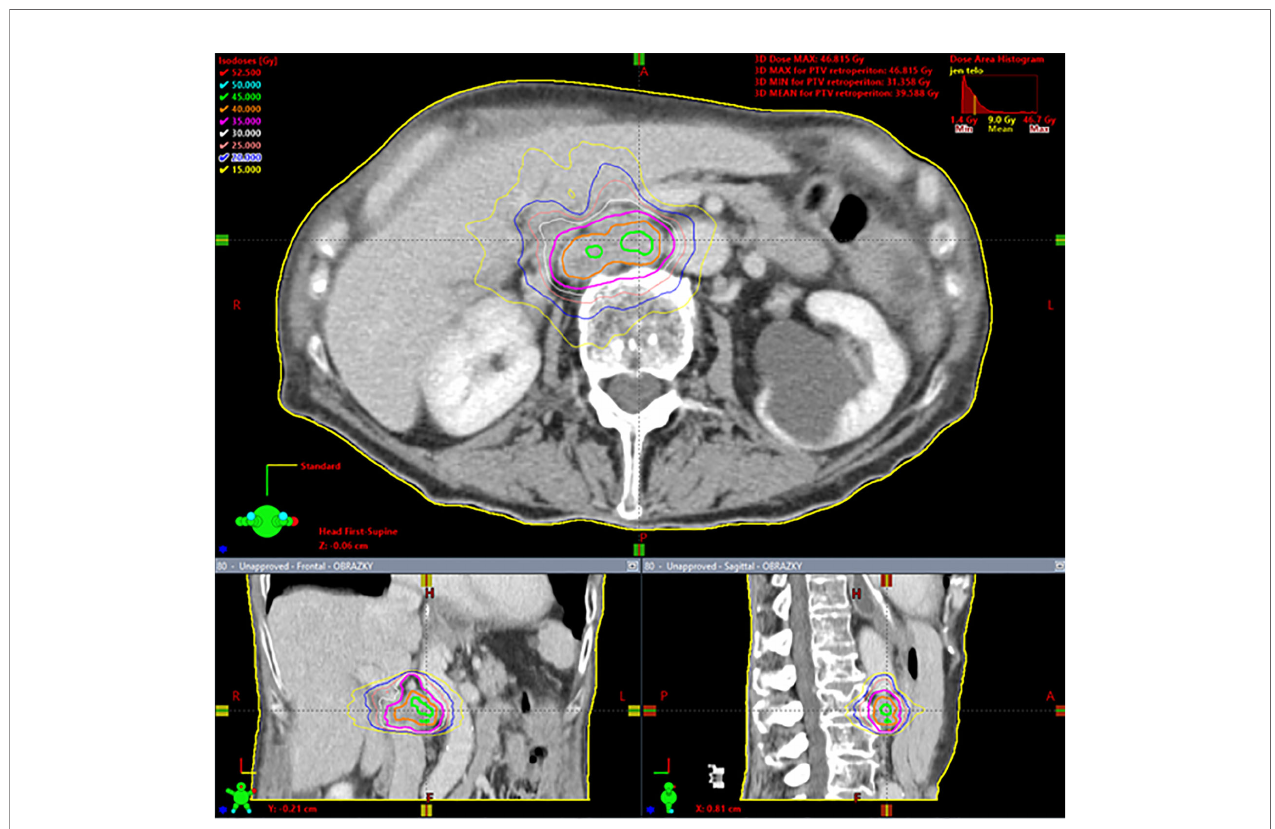
FIGURE 1 | Spinocellular carcinoma of the esophagus in a 63 year-old woman, solitary metastasis in the retroperitoneal lymph node, 35 Gy in fi ve fractions, dose prescription at 80% isodose, PTV = 29.6 cm3, Dmin = 31.4 Gy, Dnear min = 35 Gy, Dmean in PTV = 39.6 Gy, Dnear max = 45.5 Gy, Dmax = 46.8 Gy. Gy, Gray; PTV, planning target volume; Dmin, minimum dose in the PTV; Dnear min, near-minimum dose in the PTV; Dmean in PTV, mean dose in PTV; Dnear max, near- maximum dose in the PTV; Dmax, maximum dose inthe PTV. Dnear min and Dnear max according to ICRU report 83